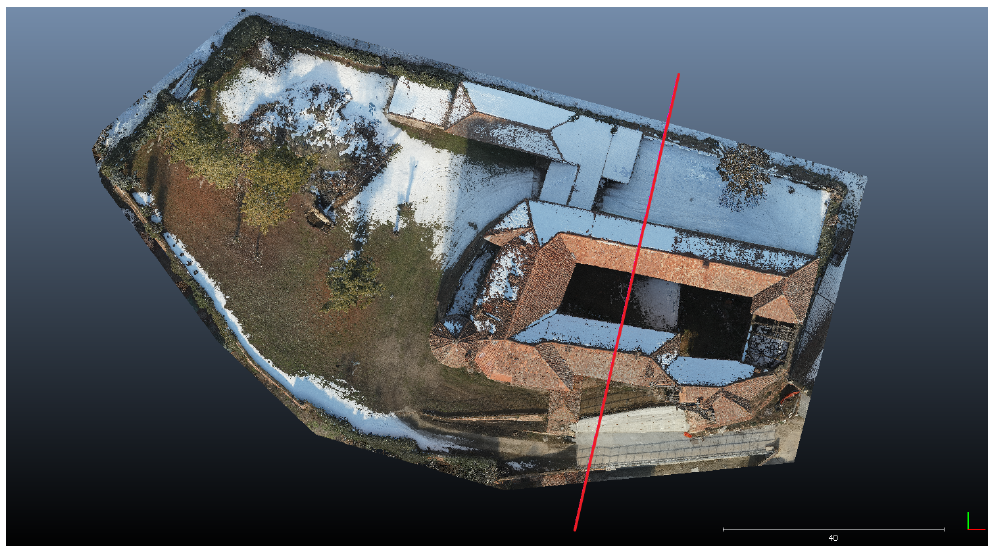
Figure 16. Profile 2: from north to south wings of the